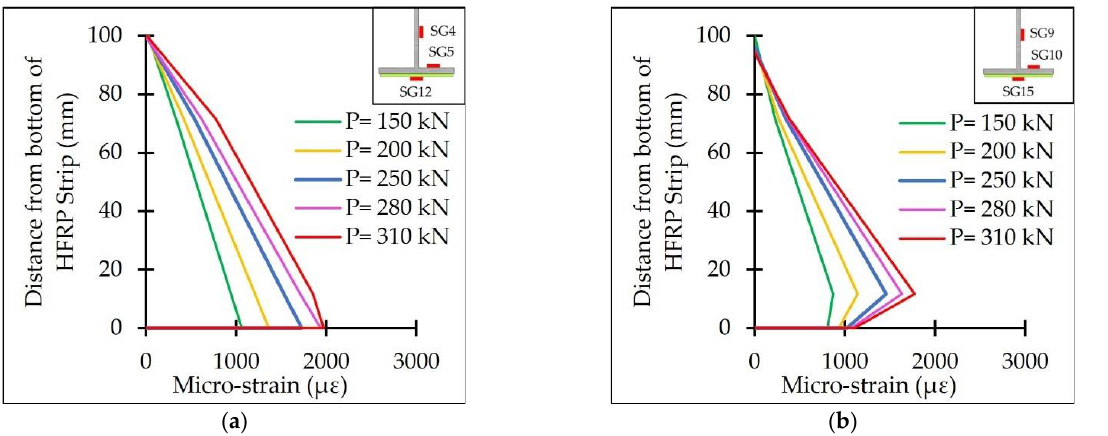
Figure 20. Distribution of the tensile strains of 1620-S-100 at: ( a ) mid-segment; ( b ) edge-segment.